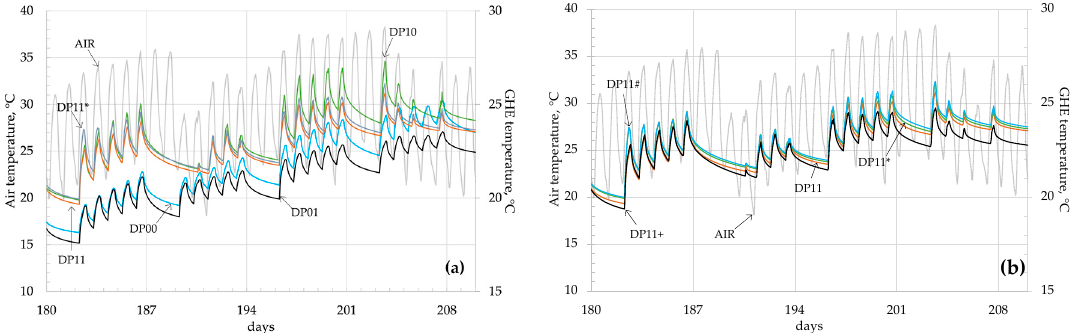
Figure 10. Details of summer temperatures ( a ) for cases DP00, DP01, DP10, DP11 and ( b ) DP11, DP11*, DP11#, DP11+.